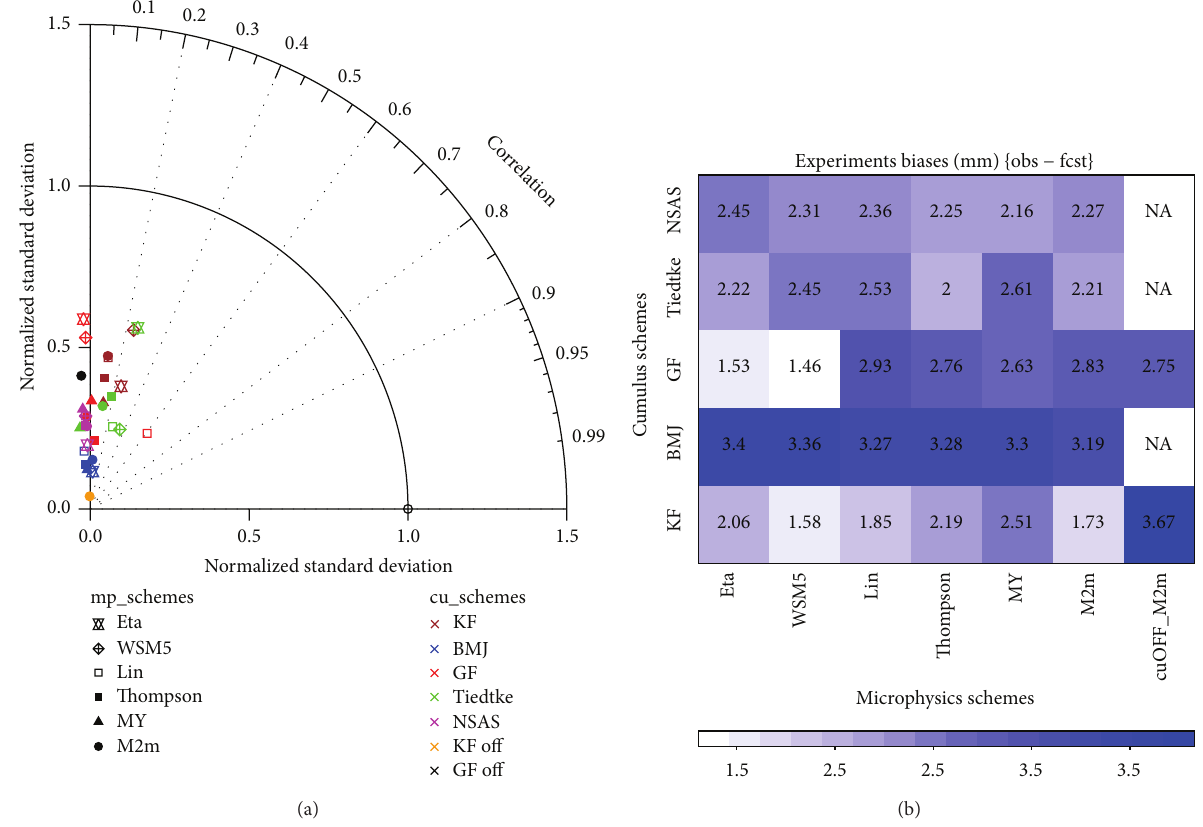
Figure 8: Taylor diagram (a) and experiments biases (b) for 6 hours of cumulative precipitation and for all experiments. The symbols (a) refer to microphysics schemes while the colors refer to cumulus schemes. Valid for 0600 UTC, 2 May 2012. Biases computed as observed minus each experiment forecast. Positive (blue) values indicate the forecast underestimates observation values. microphysics with KF and Tiedtke cumulus parameteriza- tions and Tiedtke Lin kept correlation values above